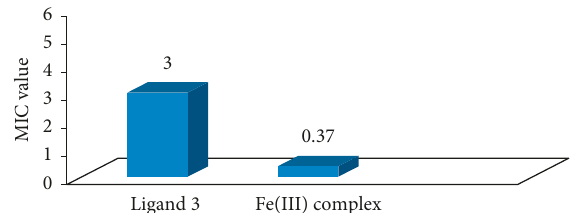
Figure 10: MIC values of ligand 3 (L) and its metal complex against S. albus ( G +ve).